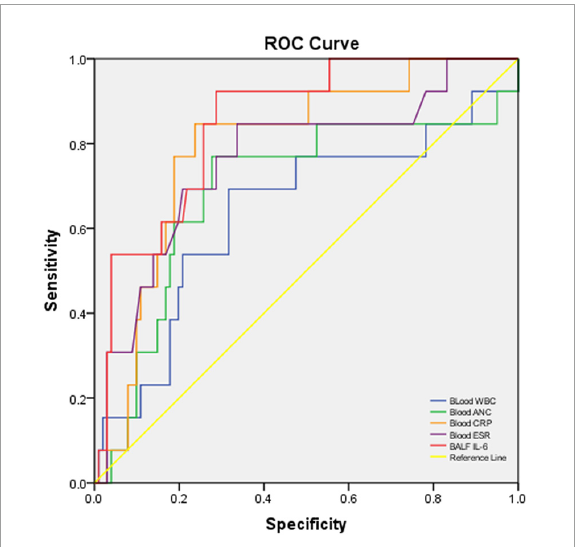
FIGURE2 ROC curve of blood WBC, ANC, CRP, ESR, and BALF IL-6 for discriminating severe vs. non-severe CAP cases. The AUC and p -values of each blood biomarker and BALF IL-6 are listed in Table 2